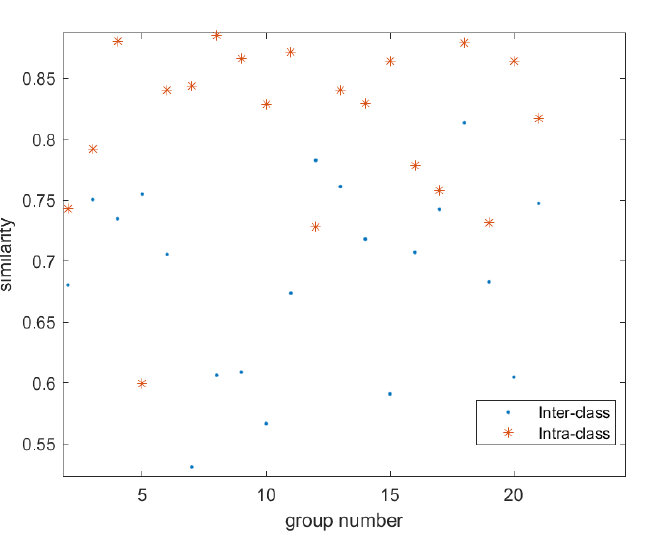
Figure 3. Scatter diagram of image similarity. The abscissa represents the number of sample groups, and the ordinate represents the sample